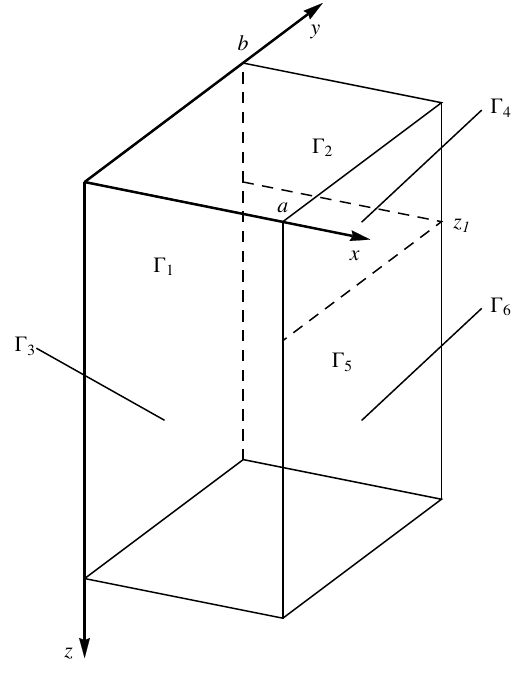
Figure 1. Domain of the